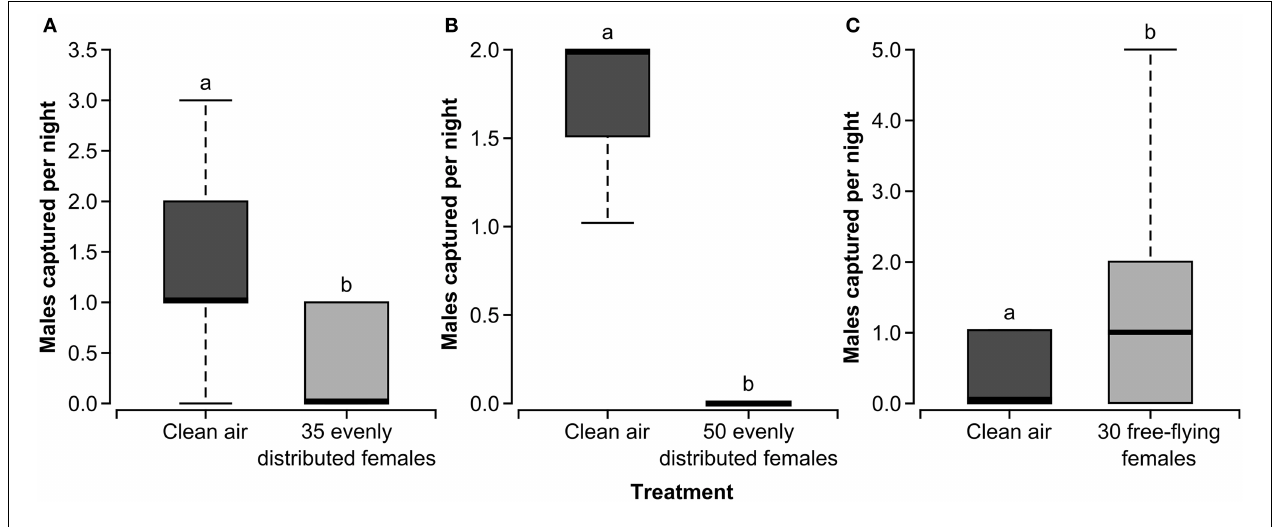
bottom of the box, respectively. The midline indicates the median and the vertical lines extending from the box (whiskers) represent the maximum and minimum values. Data are based on the release of 30 (A,C) and fifty (B) males in each cage for each replicate. Within a panel, bars with different letters are significantly different (GLM, P < 0 . 05